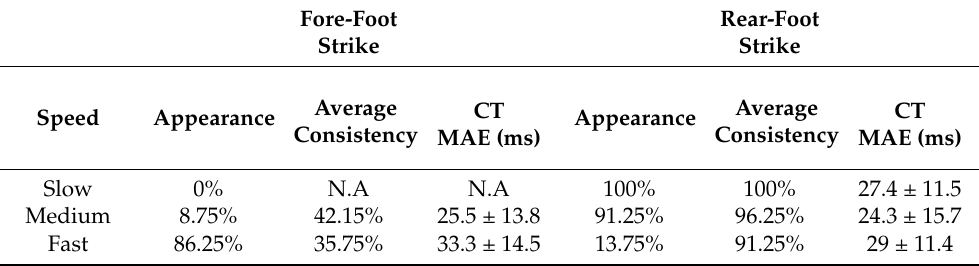
Table 4. The consistency of the two systems under different speed and maximum tolerance value of the confidence